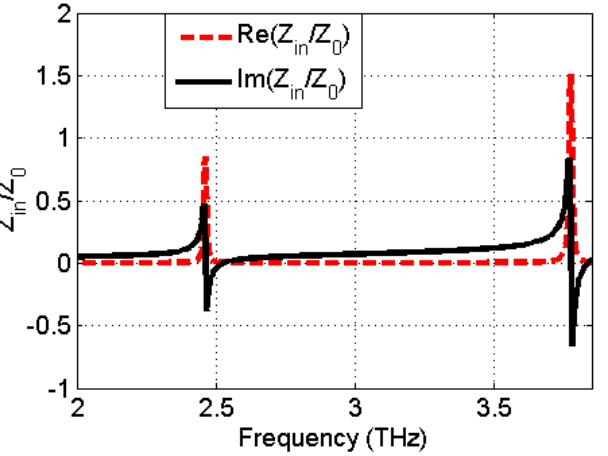
Figure 5. The normalized input impedance as function of frequency for the proposed absorber.